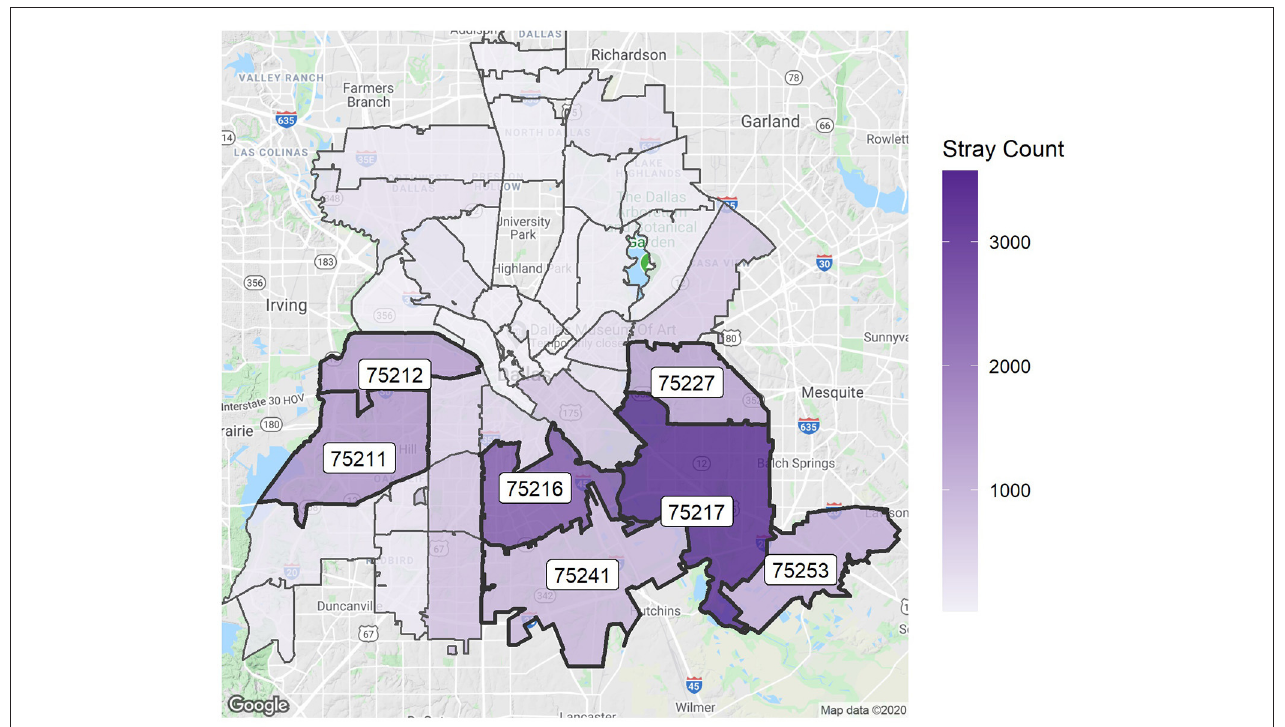
FIGURE 2 | Strays per ZIP code. The map is centered on Dallas City Hall. The seven largest areas are